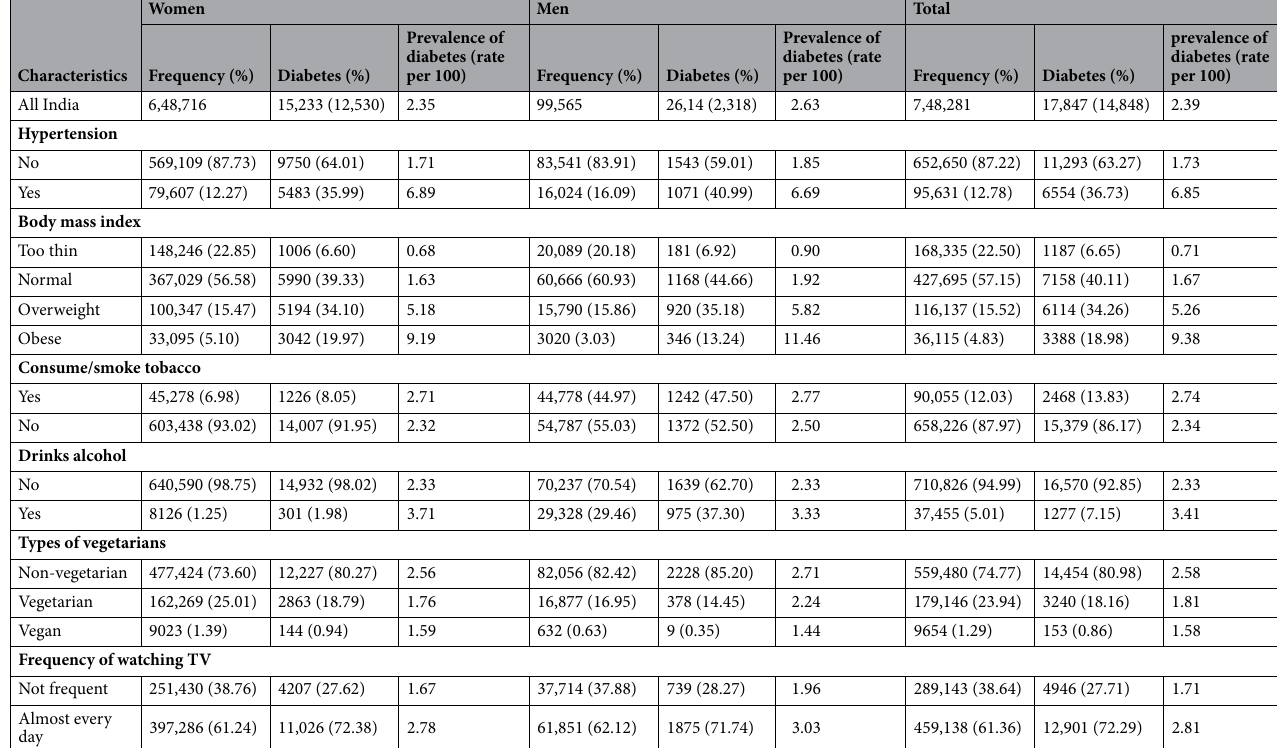
Table 4. Sample distribution and prevalence of diabetes in different risk factors for diabetes among women and men in National Family Health Survey, 2015–2016. All the values are weighted using sample survey weights from National Family Health Survey-4 and values in the parenthesis at all India level are